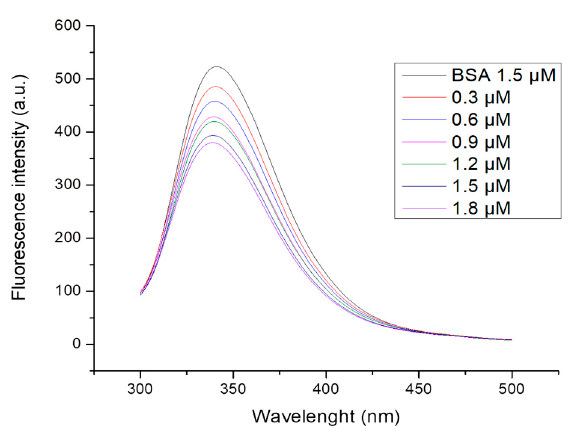
Figure 3. Fluorescence spectra of bovine serum albumin (BSA) (1.5 μ M; λ max = 341 nm) in the presence of compound 7e (0.3 μ M; 0.6 μ M; 0.9 μ M; 1.2 μ M; 1.5 μ M 1.8 μ M; λ max = 339 nm).